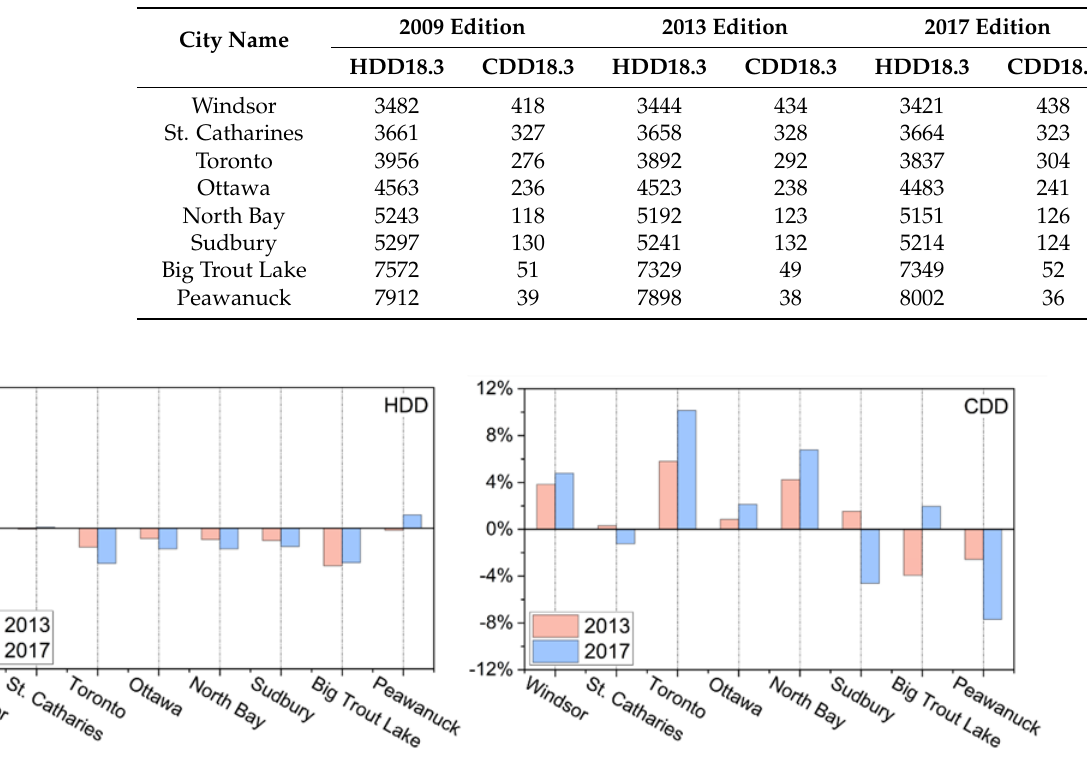
Figure 2. Changes in designed degree day for the selected cities for 2009–2013 and 2009–2017.